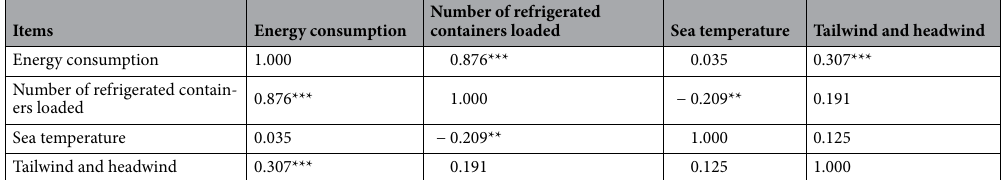
Table 3. Statistical analysis between energy consumption and the influencing factors. * P < 0.05, ** P < 0.01, *** P <